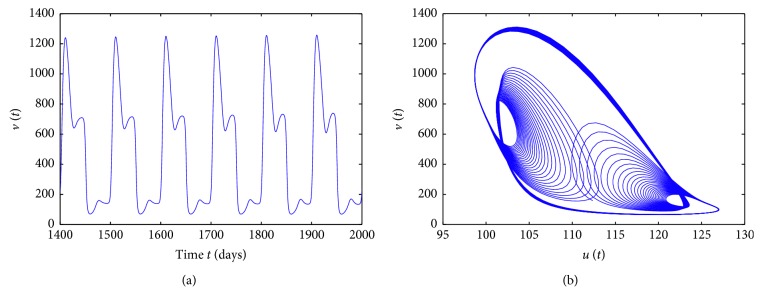
Solutions of the model for τ = 49, corresponding to Figure 7(b).